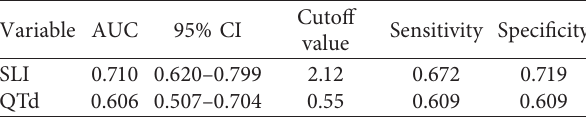
Table 5: ROC curve analyses of electrocardiographic